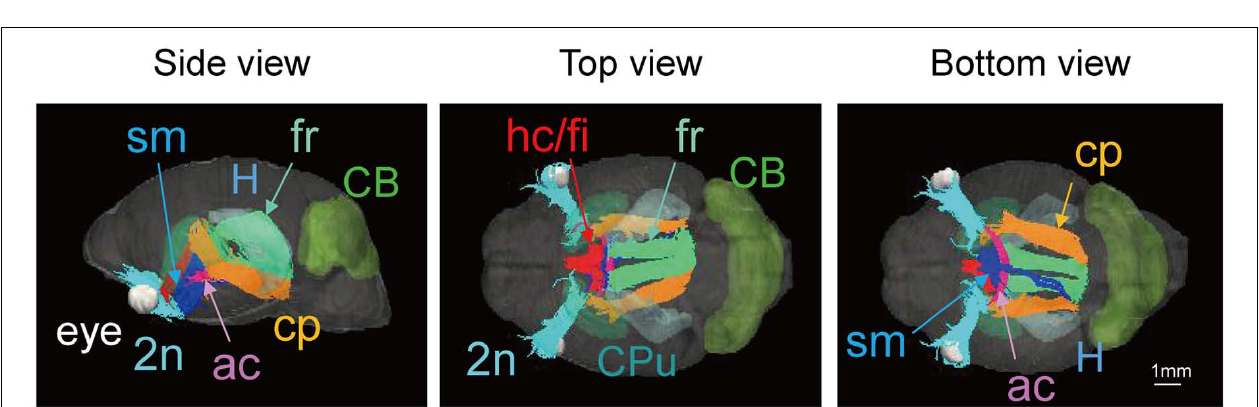
FIGURE 5 |Tractographyoftheneonatalbrain(left,sideview;center,top view;right,bottomview). 2 n ,opticnerve(lightblue);ac,anteriorcommissure (pink);cp,cerebralpeduncle(orange);fr,fasciculusretroflexus(lightgreen);